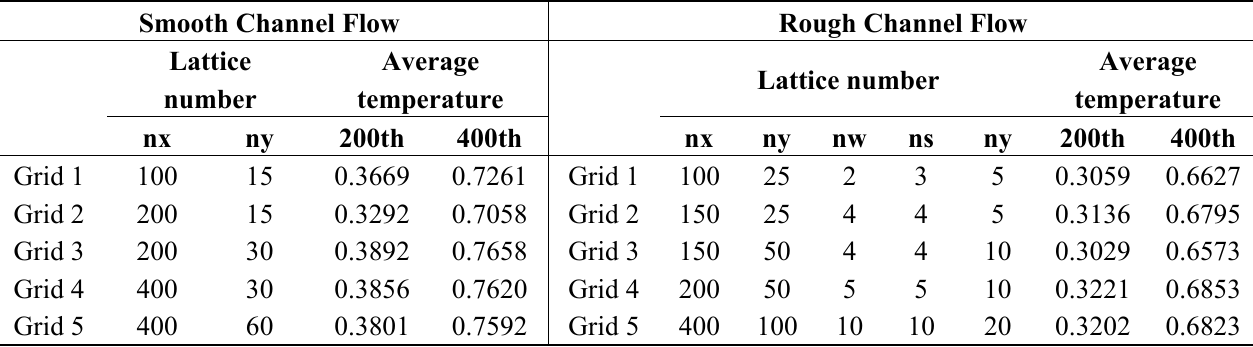
Table 1. Lattice independence